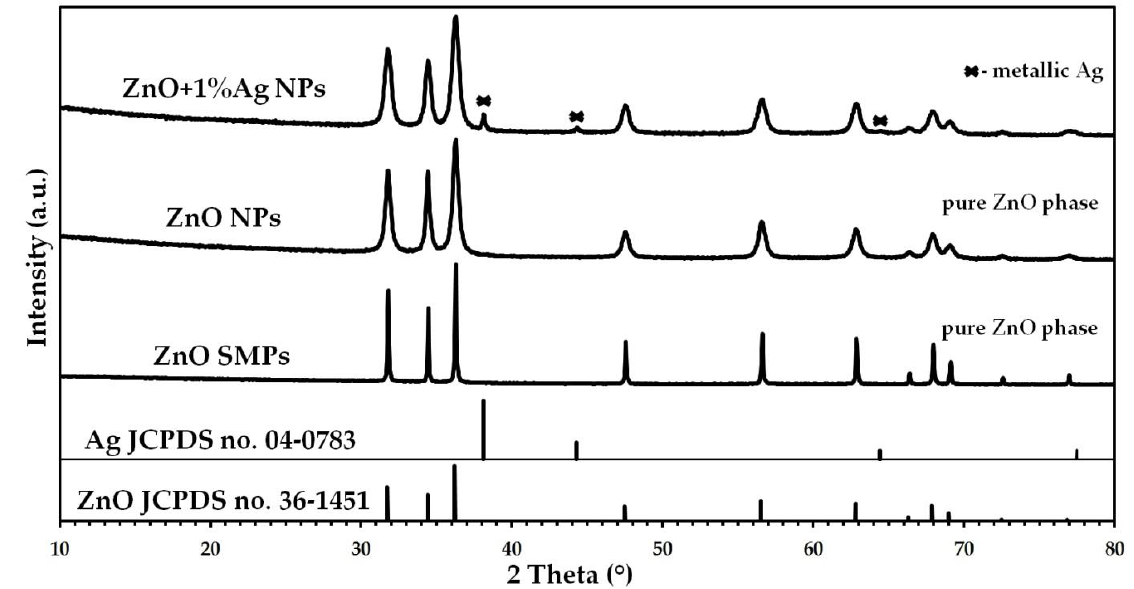
Figure 3. X-ray diffraction patterns of ZnO NPs, ZnO+1%Ag NPs and ZnO SMPs.